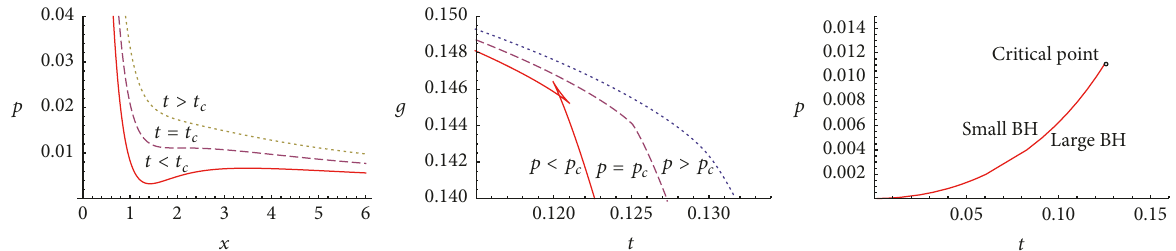
Figure 1: Born-Infeld AdS black holes for 𝑑 = 4 and 𝑤 2 = −0.1 . There is one critical point, which corresponds to VdW-like SBH/LBH phase transition when 𝑡 < 𝑡 𝑐 . Here the critical pressure and temperature read 𝑝 = 𝑝 𝑐 ≈ 0.011986 and 𝑡 = 𝑡 𝑐 ≈ 0.125087 , respectively.